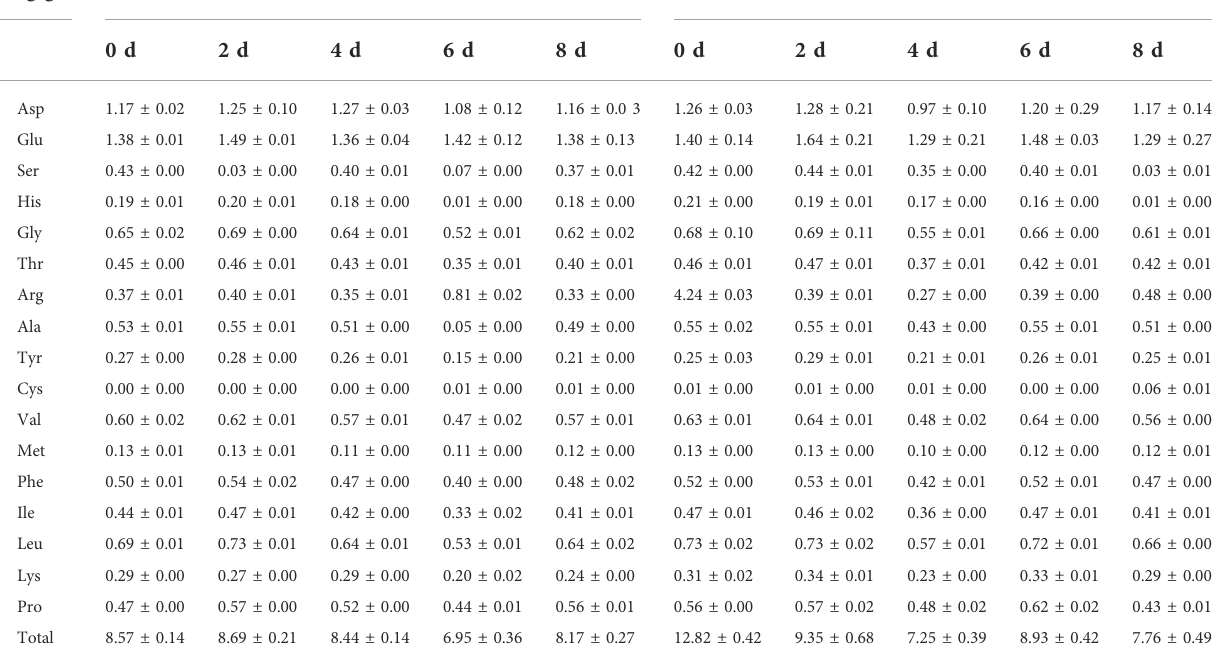
TABLE 2 Effects of fermentation medium on amino acid composition of cigar leaf. Control group Amino acid (mg/g)